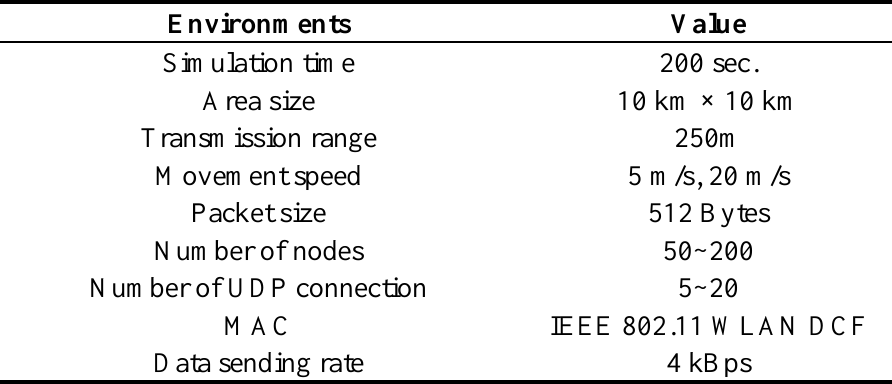
Table 2 . Simulation